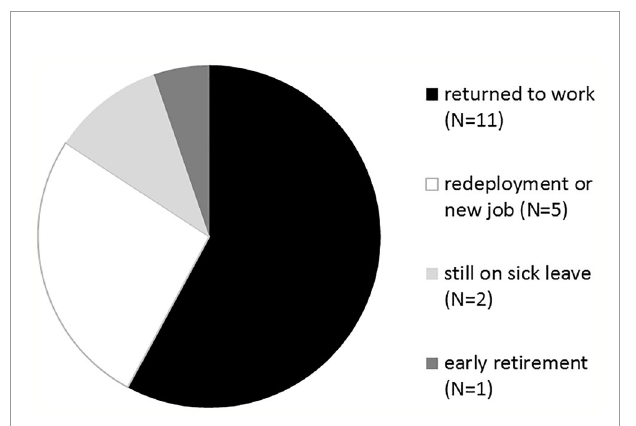
FIGURE 4 | Dynamics of depression ratings (T0: before fi rst treatment session; T1: after last treatment